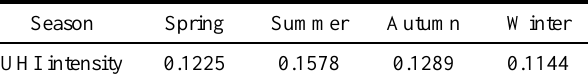
Table 2. Urban heat island index under different seasons